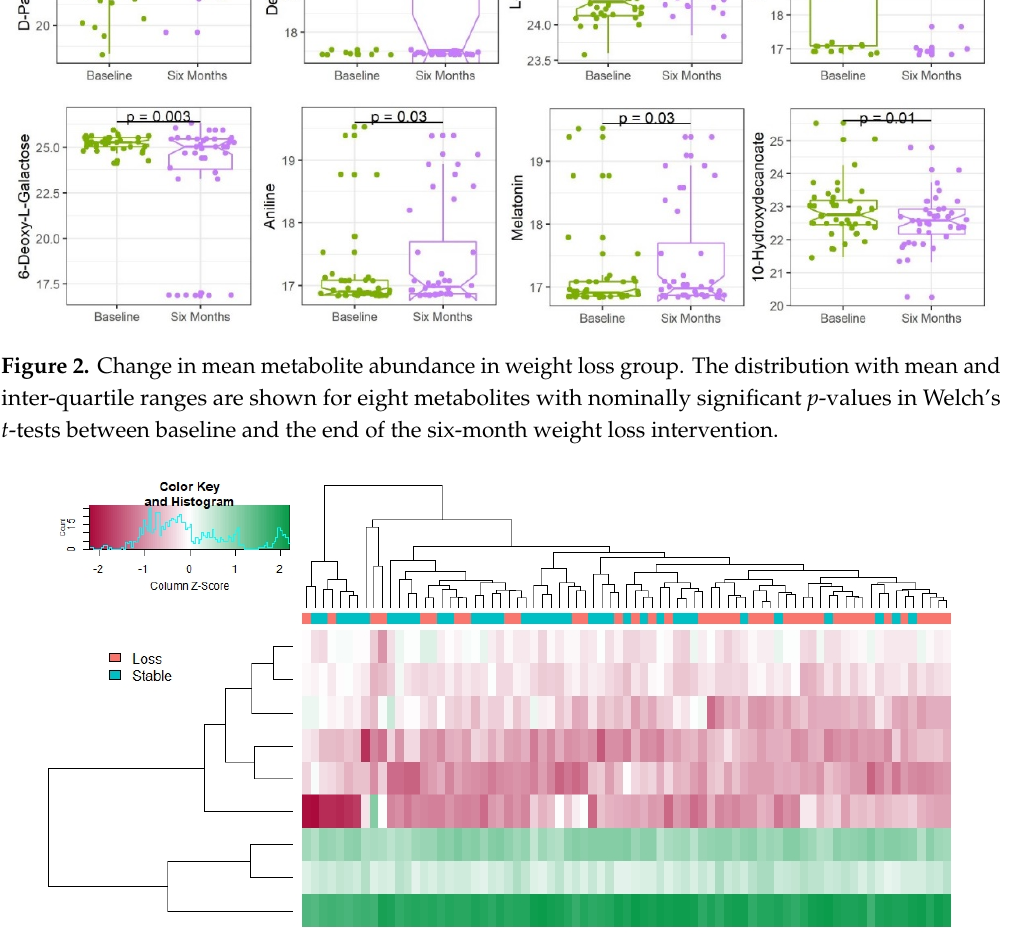
Figure 3. Heatmap of di ff erentially expressed metabolites between weight loss (WL) and weight stable (WS) groups at the end of the intervention. Based on metabolites with nominally significant ( p < 0.05) Welch’s t -tests results comparing the groups at the six month time point, this heatmap shows clustering of highly expressed (green) and lowly expressed (red) metabolites. The dendrogram at the top clusters individuals based on the similarity of their metabolite profiles with individuals in the WL group in orange and the WS group in